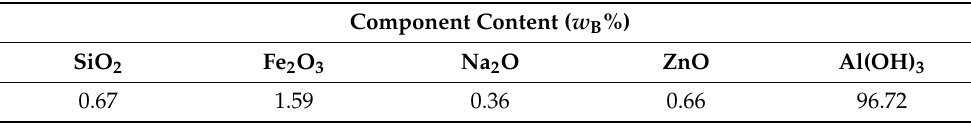
Table 1. Components of industrial aluminum